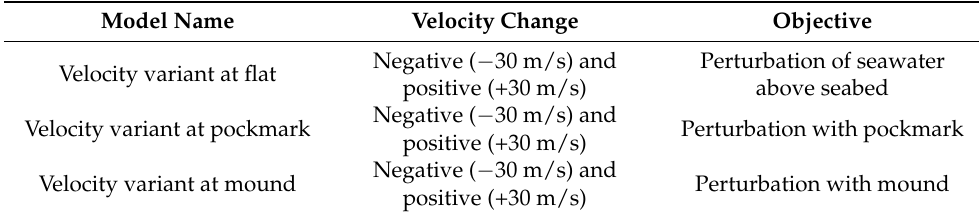
Table 2. Tested input models for acoustic velocity